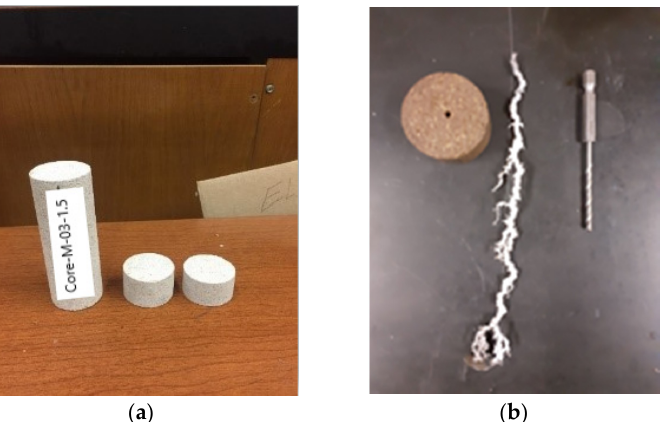
Figure 2. Core preparation. ( a ) Core is cut and drilled; ( b ) the 1/16-in drill bit used to simulate a wormhole. a